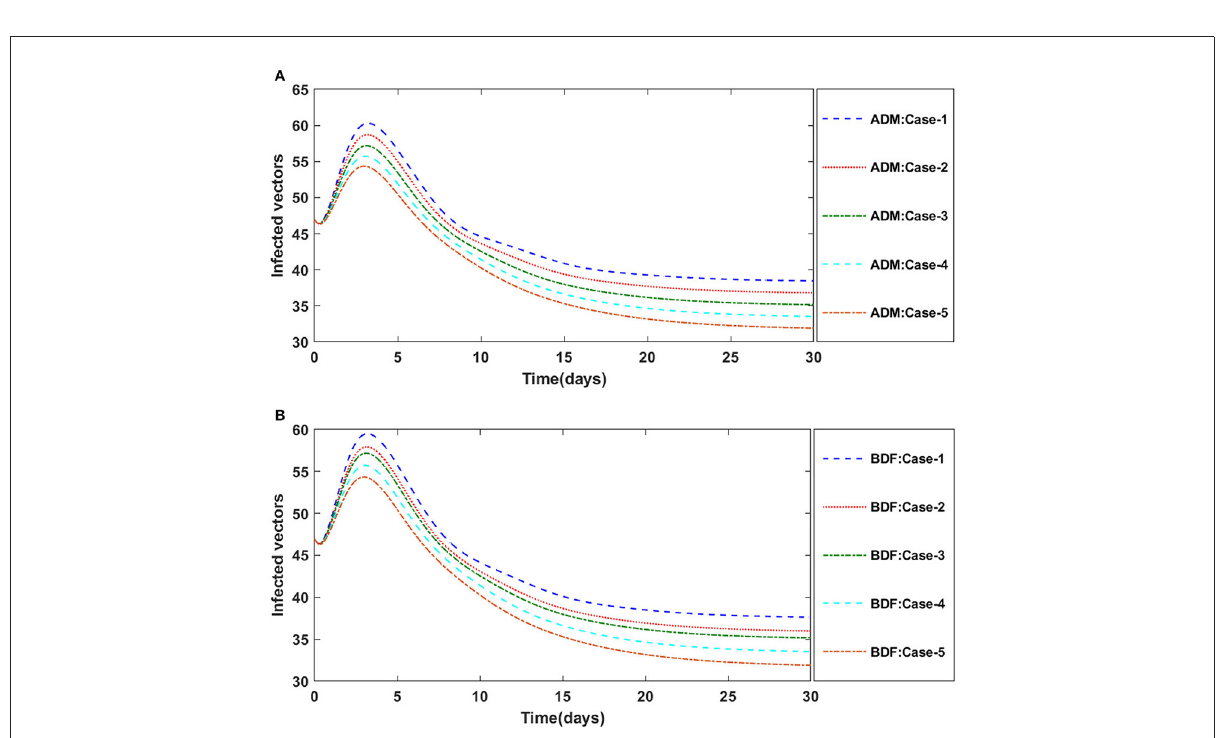
FIGURE9 (A) Dynamics of susceptible vectors for the varition in r using ADM for model A1. (B) Dynamics of susceptible vectors for the varition in r using BDF for model